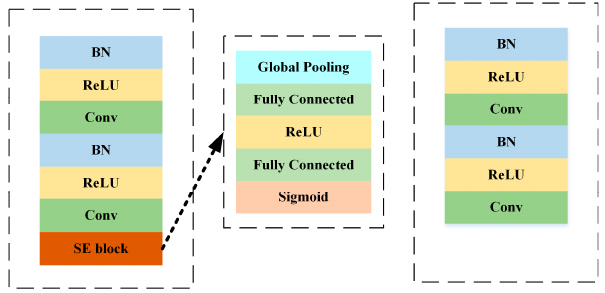
Figure 7. Network structure of SE-ResNet and ResNet.